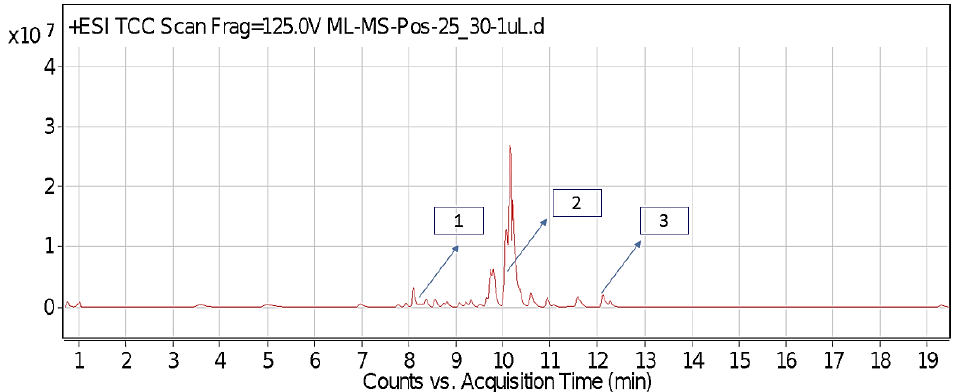
Figure 1. LC-MS chromatograms showing the phytotoxic compound positive ion mode of P. hysterophorus leaf methanolic extract (1. Chlorogenic acid, 2. Parthenin, and 3. Quinic acid).